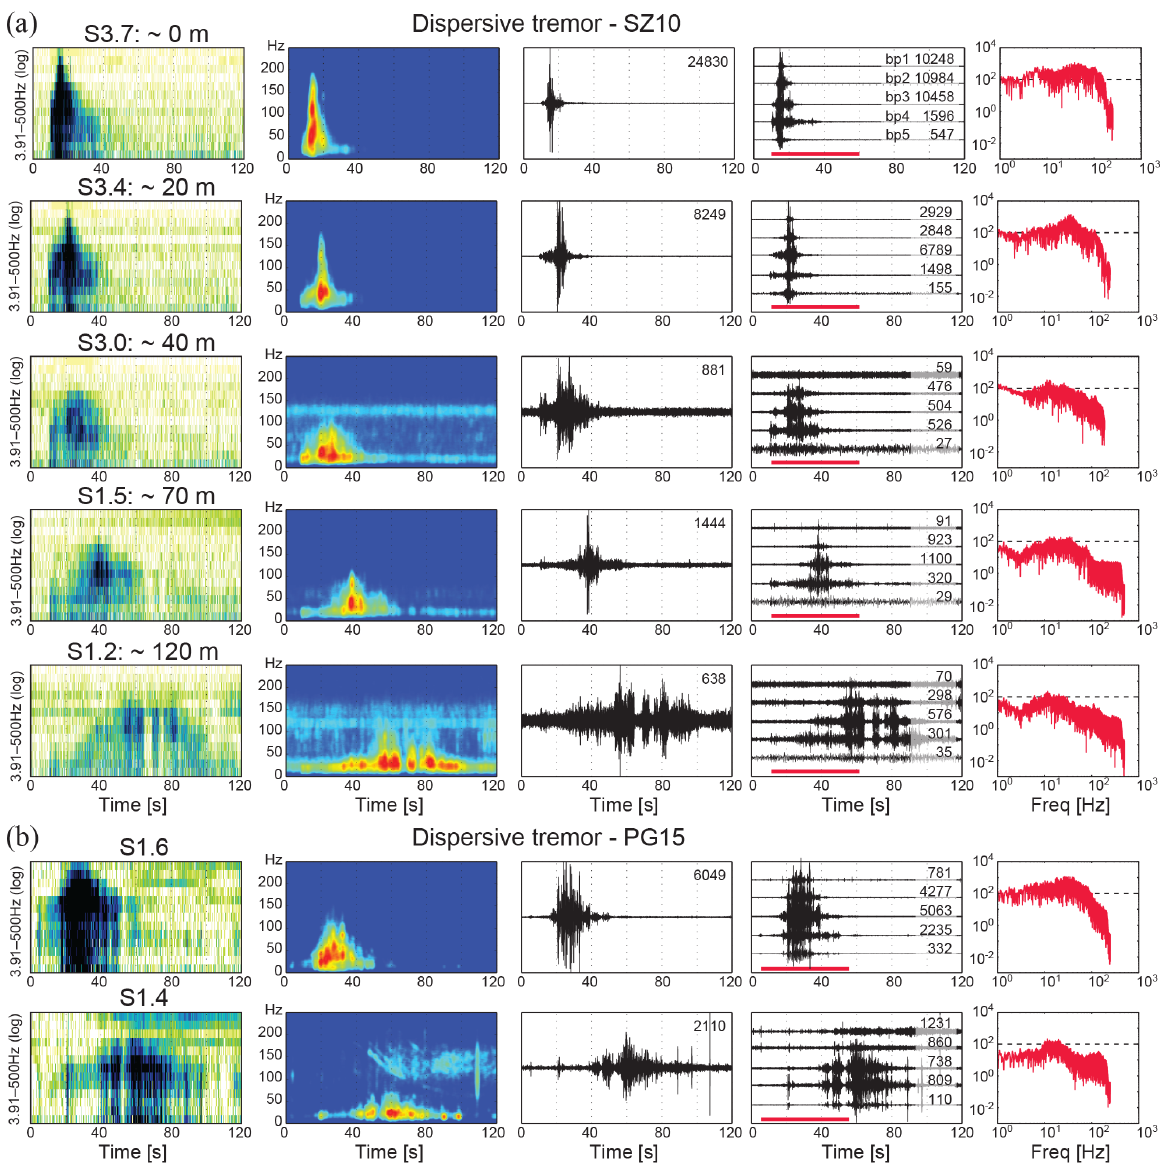
Figure 7. Seismic features of two dispersive tremor events recorded at (a) SZ10 at t 0 4 July 2010, 00:45:20 and (b) PG15 at t 0 8 October 2015, 18:02:08. Stations are indicated on top of the sonogram panels and displayed in (a) and (b) from top to bottom with increasing inferred distance from the most probable source area (SZ10 stations S3.7 and S1.2 are about 120m distant; PG15 stations S1.6 and S1.4 are about 50m from one another, so the source–receiver distance could not be estimated). Note noise contamination from an airplane (gliding harmonics in the spectrogram) was very visible at PG15 station S1.4. The airplane signal was well recorded by the complete seismic network, whereas the dispersive event is only seen at array S1